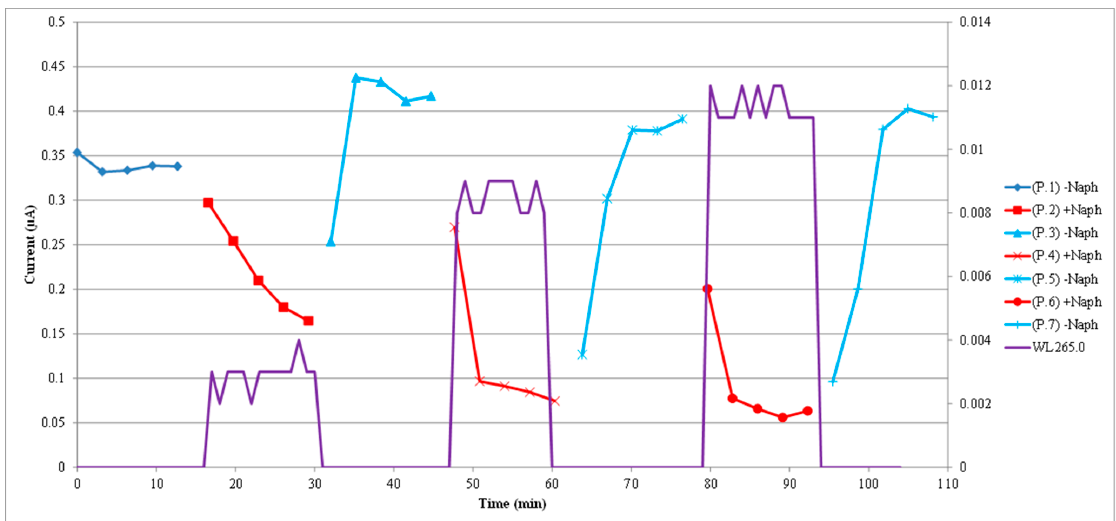
Figure 6. Three cycles with progressively increased naphthalene concentration in the respective contamination phases are shown. The last two cycles with higher naphthalene concentration show larger drop in sensor current. The red lines correspond to the naphthalene contamination phases,